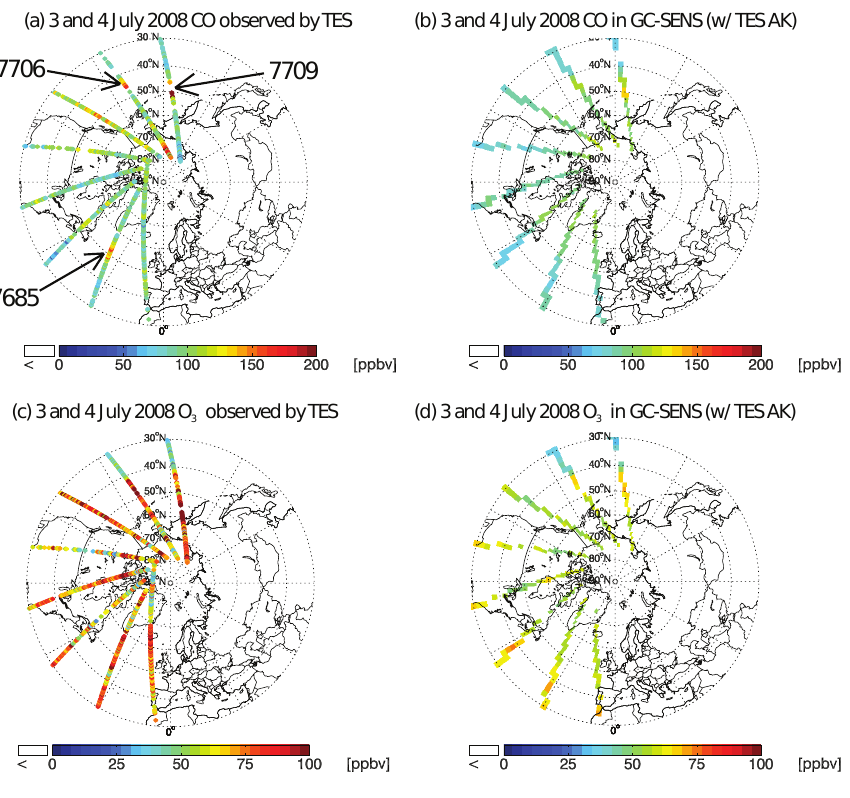
Fig. 10. Maps of (a) CO and (c) ozone mixing ratio at 510hPa from TES special observations on 3 and 4 July 2008 compared to plots of three-hour average (b) CO and (d) ozone mixing ratio at 510hPa from the GC-SENS simulations with the TES averaging kernel